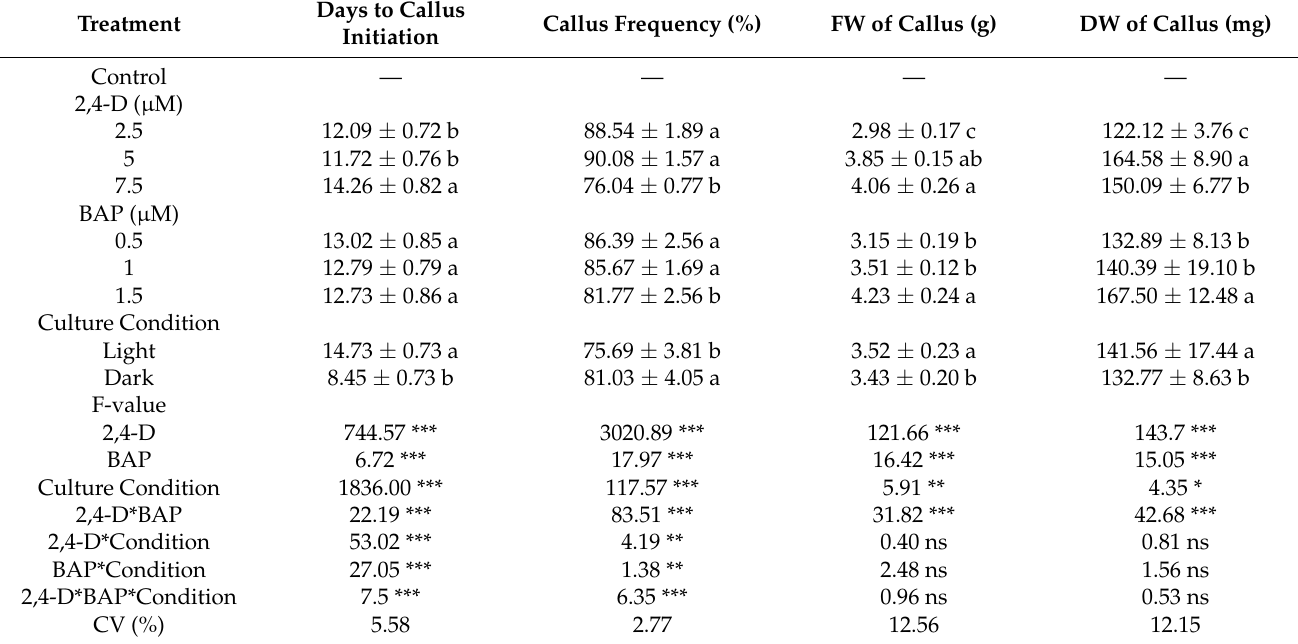
Table 1. Main effects of 2,4-D and BAP on callus induction in the nodal segment of Bougainvillea glabra under different light